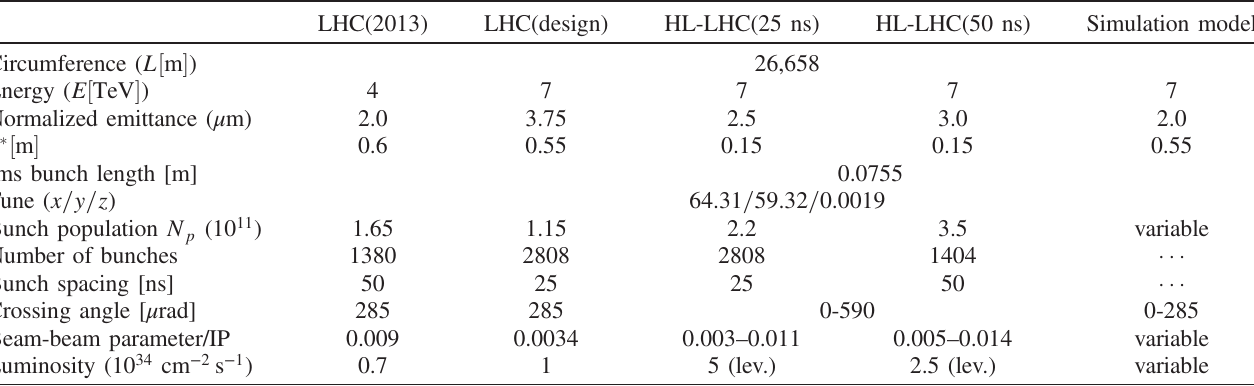
TABLE I. Parameters for LHC and HL-LHC. Two parameter sets are quoted for the HL-LHC, referring to the baseline bunch spacing of 25 ns and to a backup option of 50 ns,